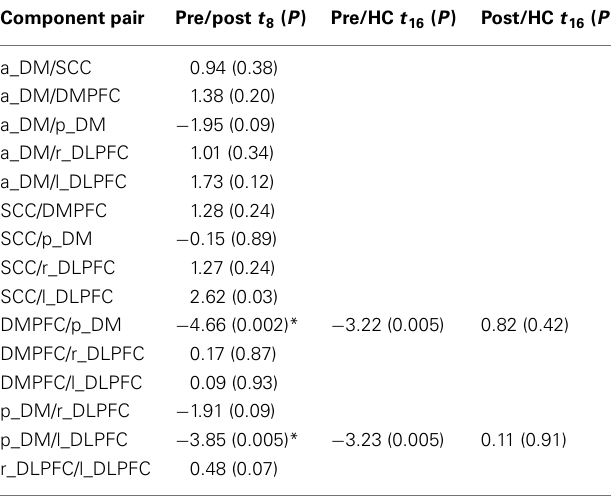
Table 3 | Functional network connectivity (FNC) results are shown for the paired- and two-sample t